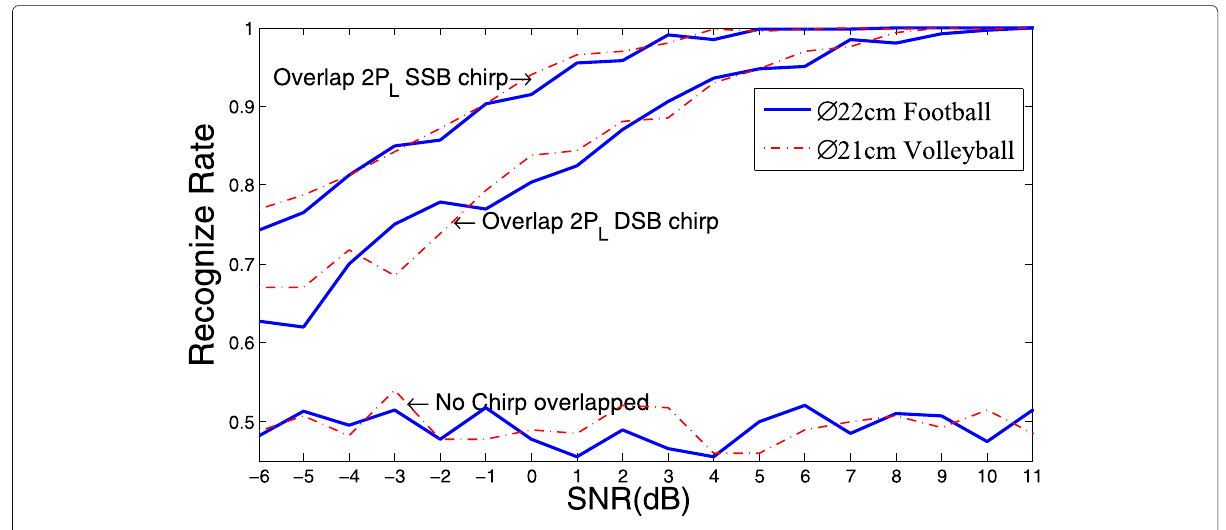
Fig. 10 Football and volleyball recognition